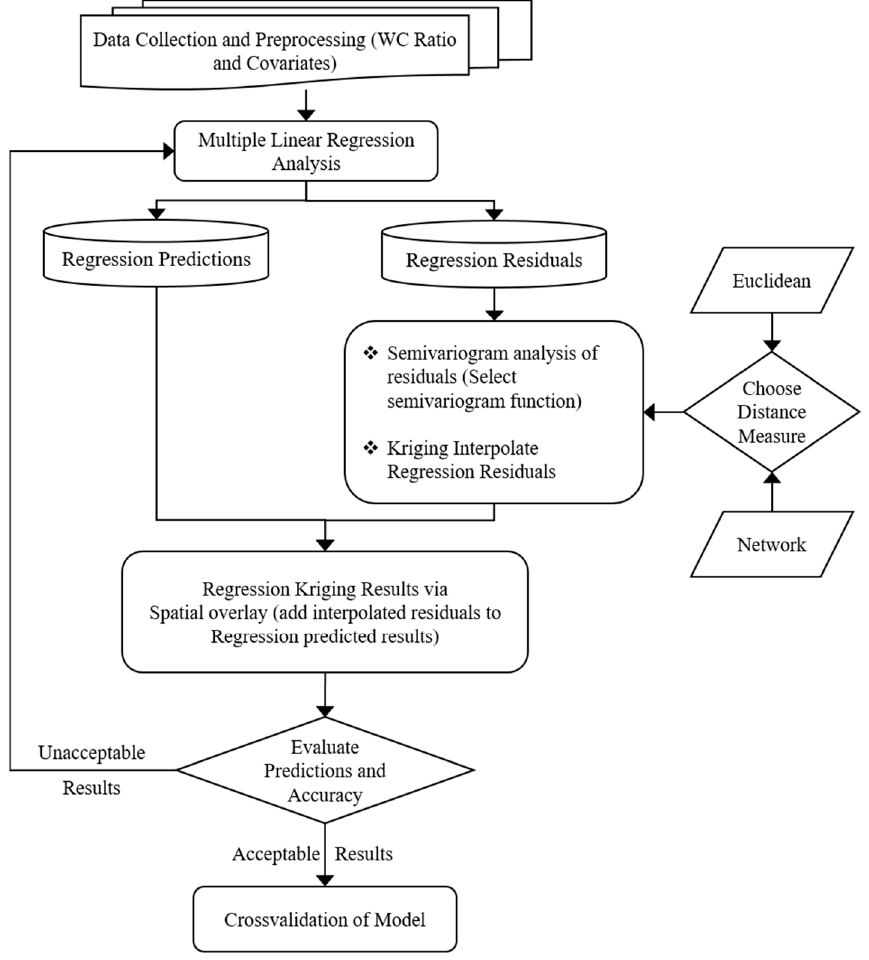
Figure 9. Simplified map of the Regression Kriging method.